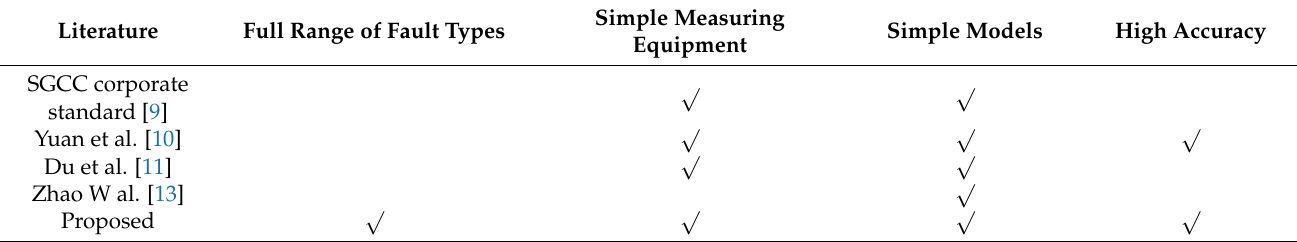
Table 1. Comparison of existing diagnostic